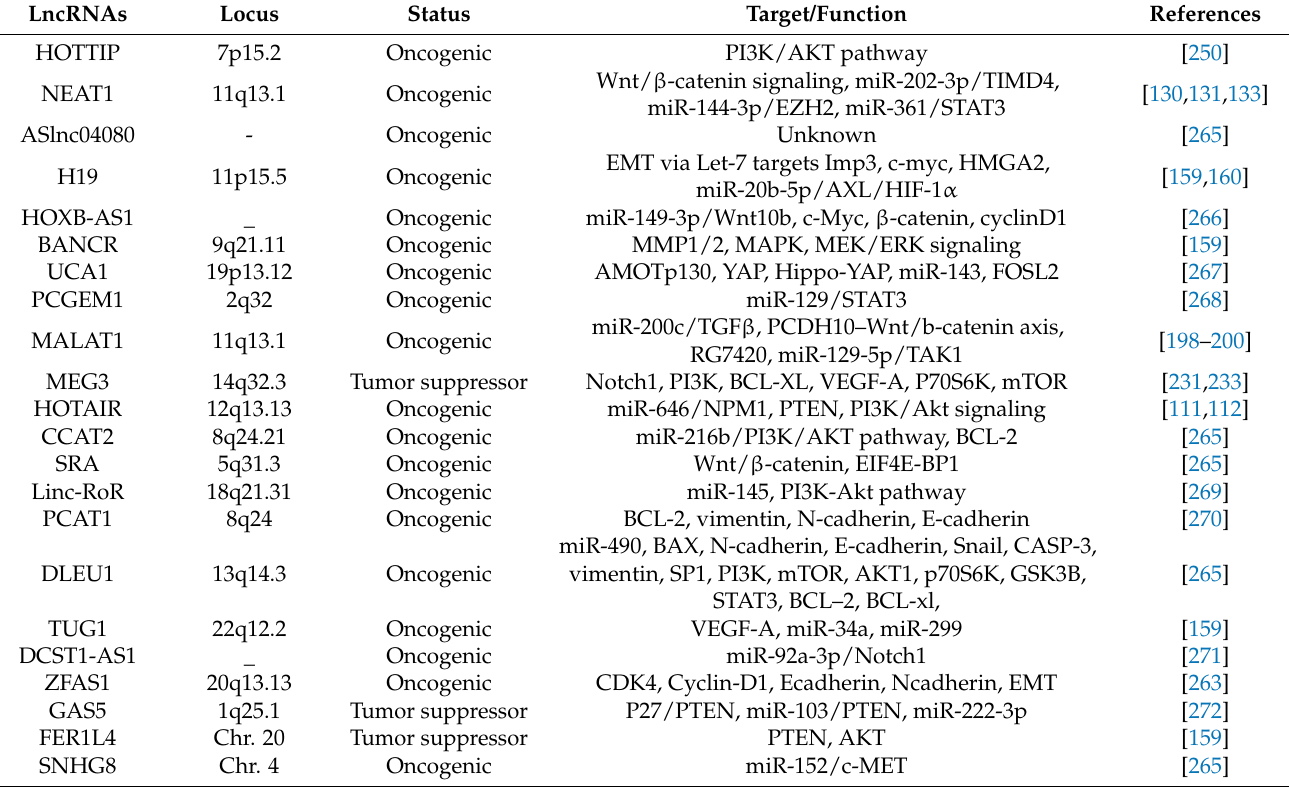
Table 2. LncRNAs involved in proliferation, invasion, apoptosis, migration, metastasis, and drug resistance in endometrial cancers.